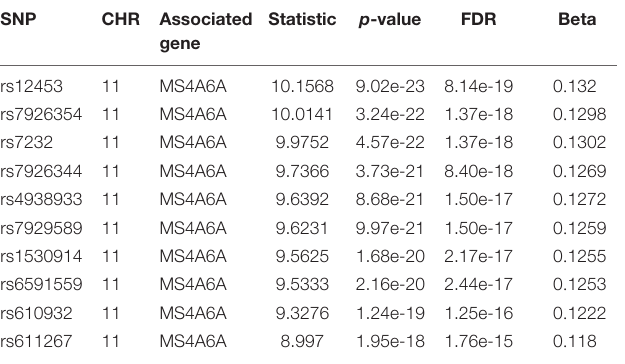
( p = 3.58e-17, FDR = 1.9e-14; Supplementary Table S2 ).